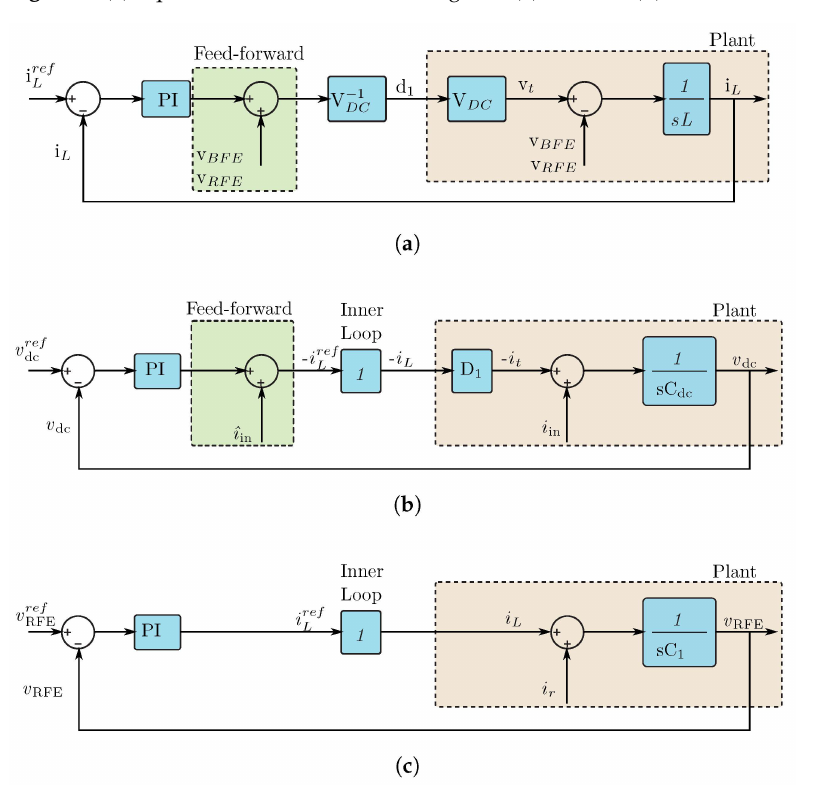
Figure 9. Control loops: ( a ) inductor current, ( b ) DC link voltage control loop, and ( c ) RFE terminal voltage control loop.